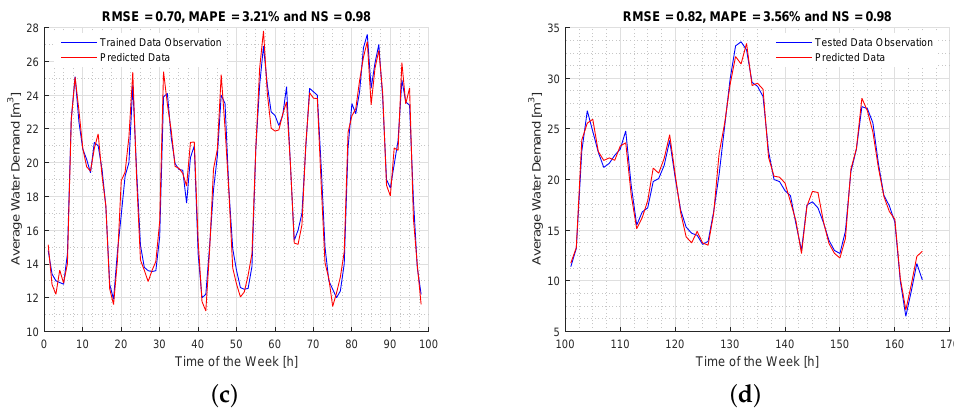
Figure 4. Forecasts generated using ( a , b ) FFBP-NN model and ( c , d ) Hybrid model. The hybrid forecast was obtained by the combined forecast from ARMA and FFBP-NN.